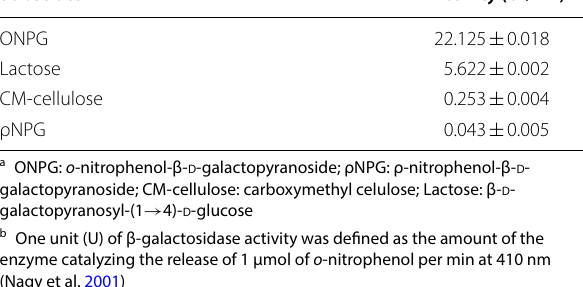
Table 5 Substrate specificity of β-galactosidase partially purified from Aspergillus niger